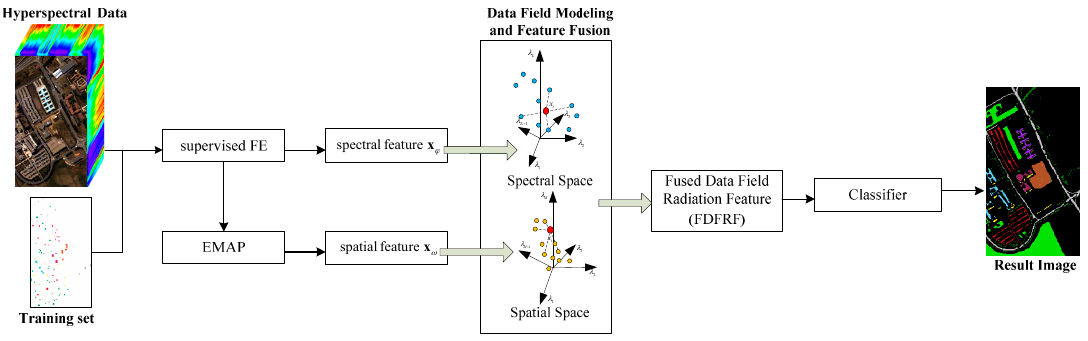
Figure 1. The implementation scheme of the proposed algorithm.